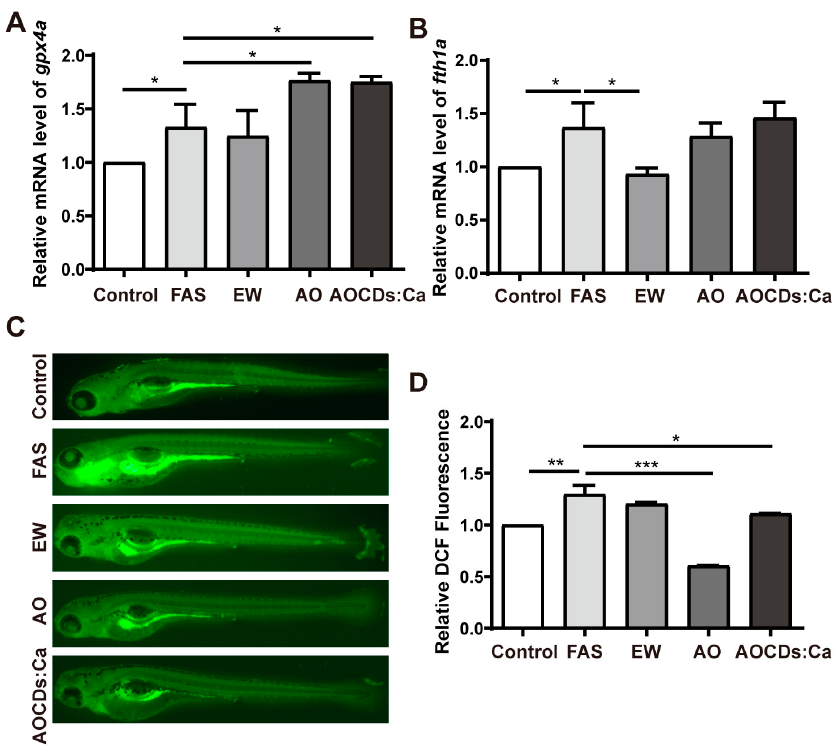
Figure 4. Antioxidant properties of AOCDs and AOCDs:Ca. ( A ). Relative expression level of gpx4a, ( B ). Relative expression level of fth1a, ( C ). Qualitative detection of ROS level, ( D ). Relative quantitative analysis of ROS content ( n = 3, t -test, * p < 0.05, ** p < 0.01, *** p < 0.001).